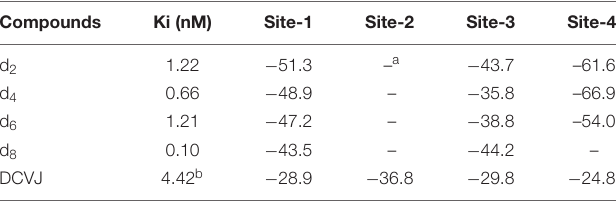
TABLE 1 | MM/GBSA free energies (kcal/mol) for DABTAs and DCV). Compounds